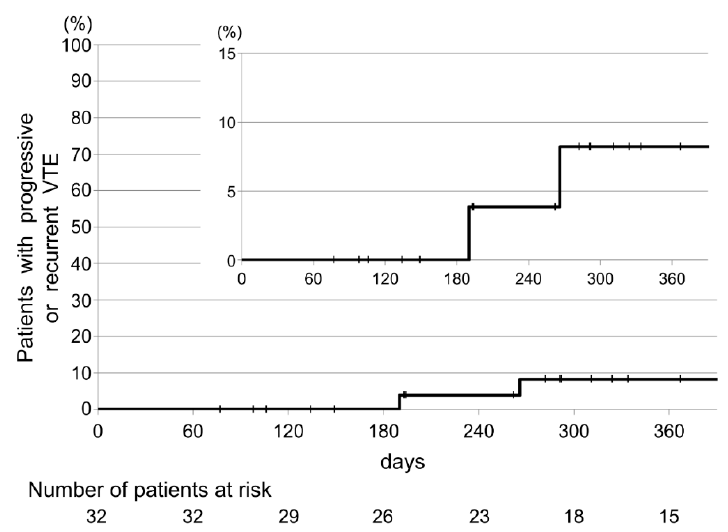
Figure 5. Kaplan–Meier cumulative-event rates for progressive or recurrent venous thromboembolism.